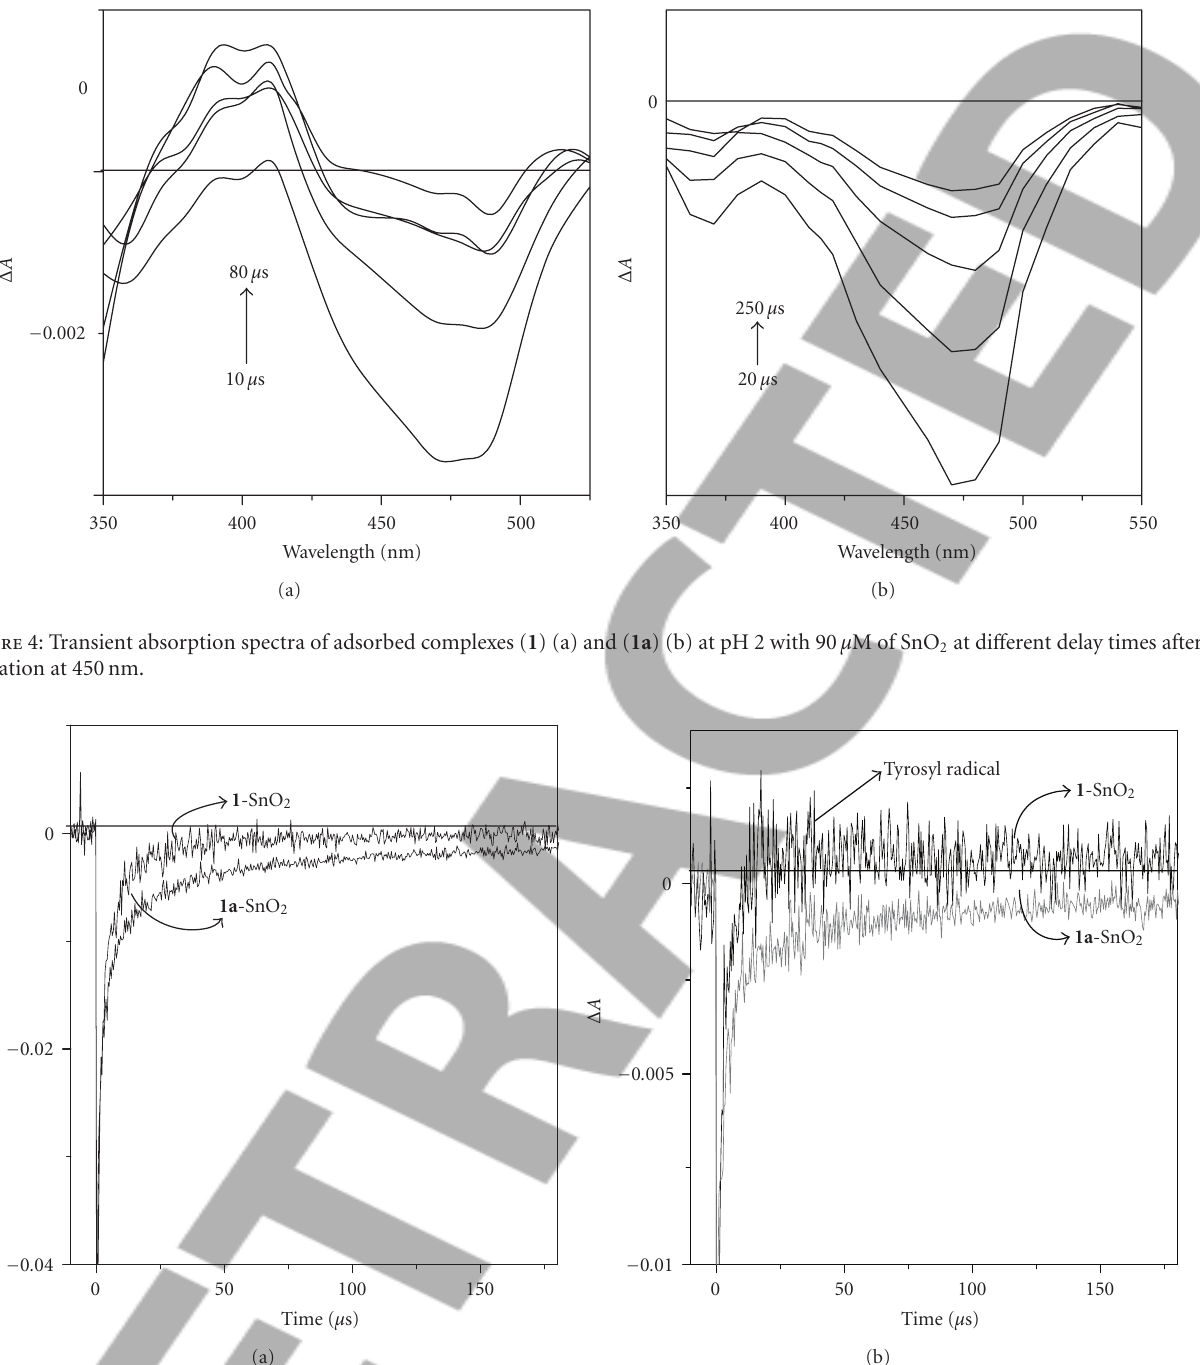
Figure 5: Kinetics of the adsorbed complexes ( 1 ) and ( 1a ) measured after 450nm excitation at pH 2 with 90 μ M of SnO 2 ; the kinetics were recorded at 470 nm (a) and at 410nm